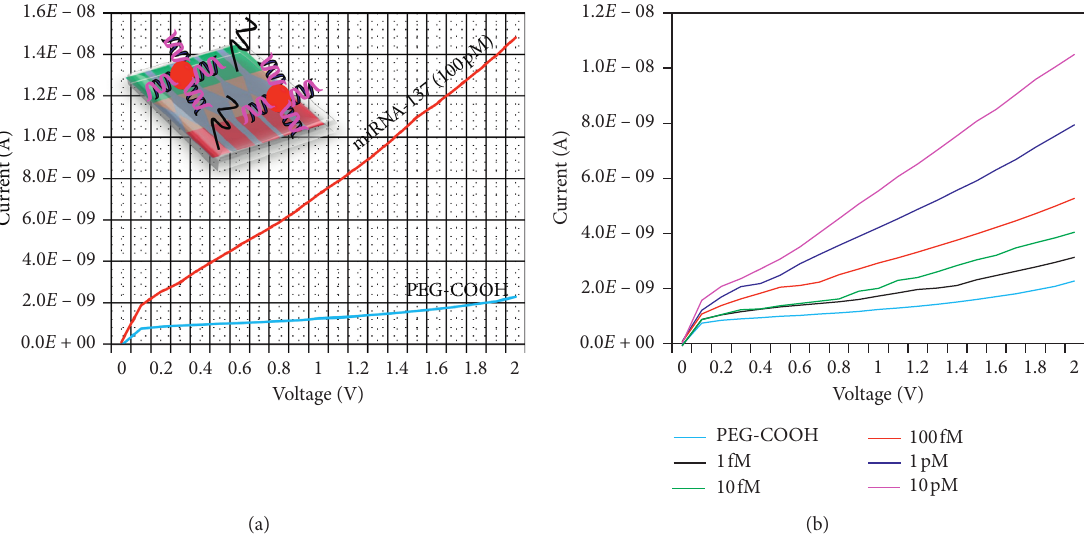
Figure 3: (a) Determination of miRNA-137 on the probe-GNS modified surface. Drastic increment of current was noted after hybridization (100pM; red line); PEG-COOH is indicated by sky blue line. (b) Different miRNA-137 hybridization levels.1fM–10pM concentrations with constant comp-miRNA-137 on the sensing surfaces. Current increment was noted with all miRNA-137 concentrations. Coloured lines are PEG-COOH (sky blue), 1fM (black), 10fM (green), 100fM (red), 1pM (blue), and 10 pM (pink).